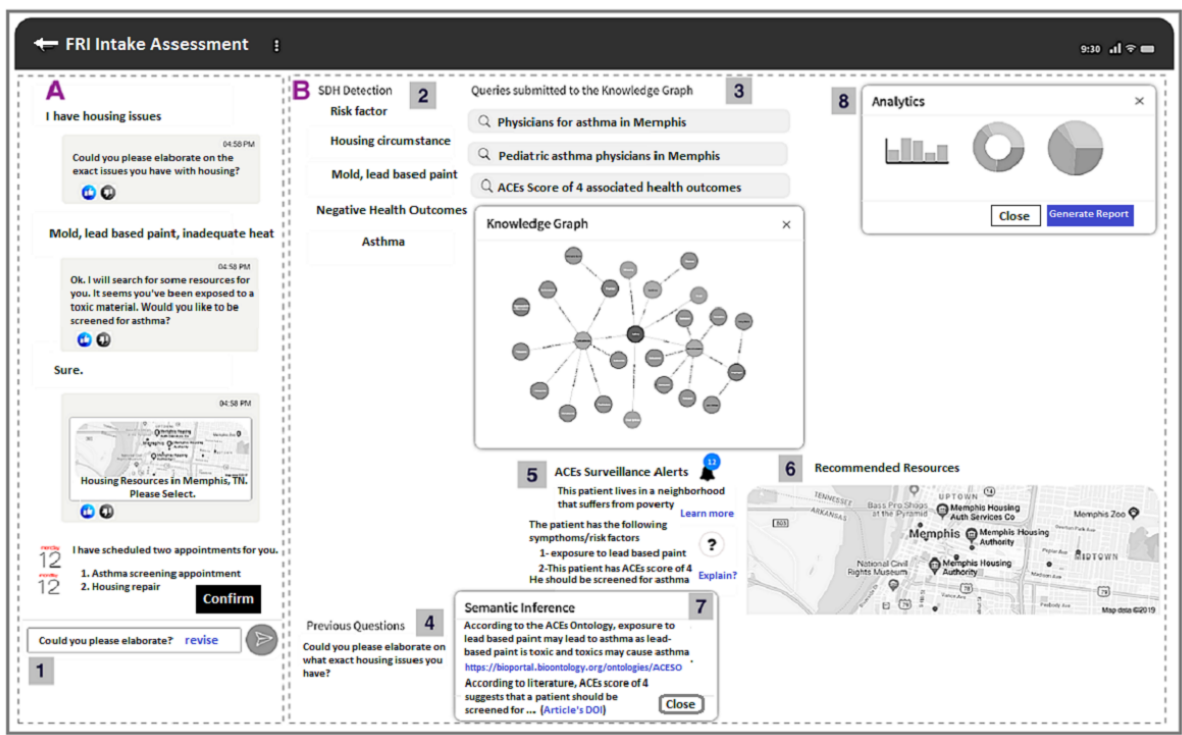
Figure 7. Prototype of the recommendation system. (A) Question-answering (QA) view (1) send/revise suggested questions. (B) Health care practitioner assessment panel, including (2) social determinants of health (SDoH) detection, (3) knowledge graph and queries, (4) pool of previously asked questions,(5) alerts for detected adverse childhood experiences (ACEs) symptoms, (6) geocoded resource allocation, (7) explain recommendations, (8) and visual